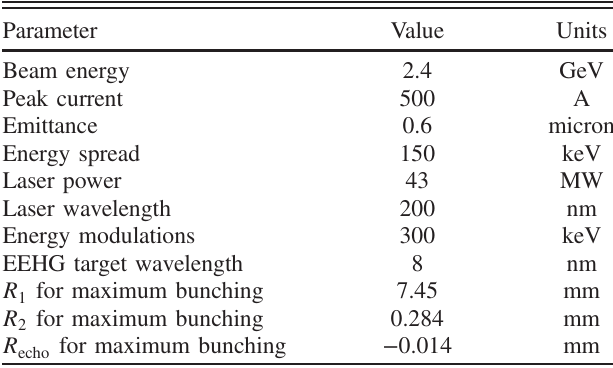
TABLE I. Electron beam and EEHG